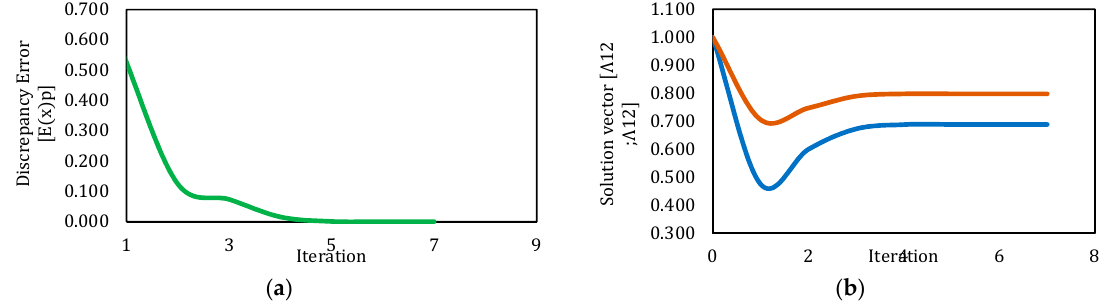
Figure 2. Behavior of discrepancy error and solution vector for Newton’s method-simulation 2. ( a ) Behavior of discrepancy error respect to iterations. ( b ) Behavior of values for solution vector respect to iterations.